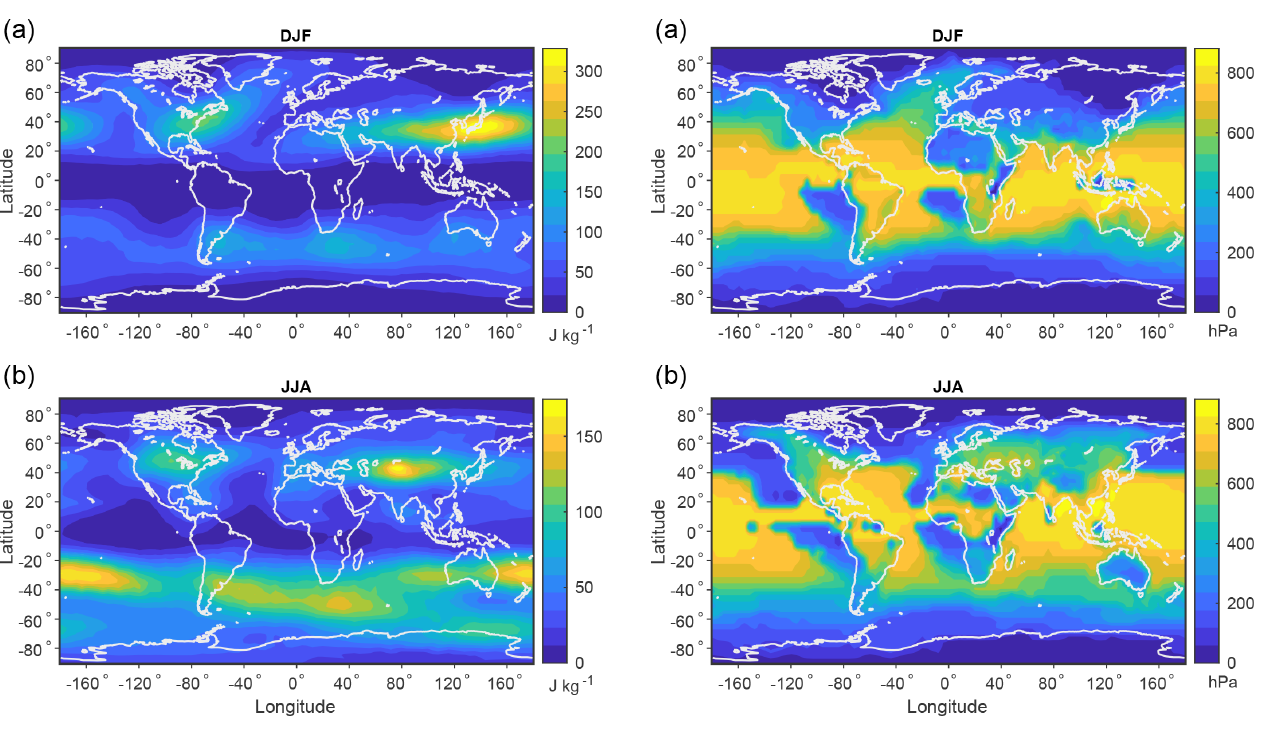
Figure 3. Local MAPE based on the climatological mean over 1979–2018 for (a) DJF and (b) JJA. MAPE is calculated on sub- domains of geodesic radius of 15 ◦ (1670km) centered in the hori- zontal on 3200 surface grid cells.